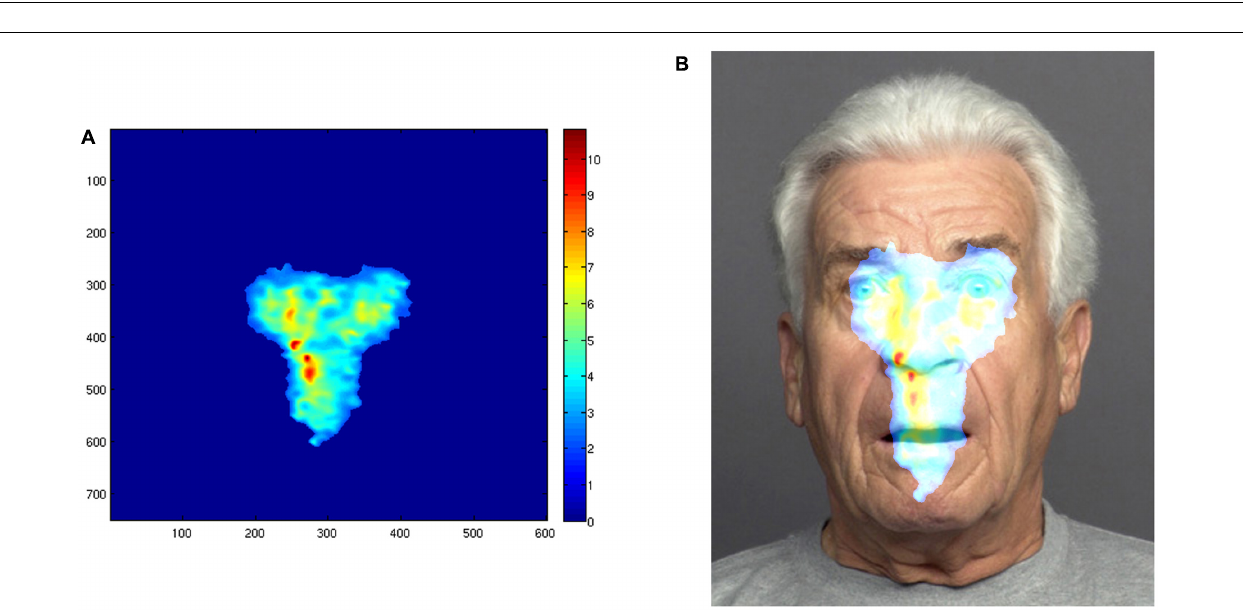
FIGURE 2 | Pixel-wise statistical map showing the number of fixations in the stimulus space of the intuitive group as revealed by the i Map3 analysis. (A) The statistical pattern of distribution of fixations. The colors of the map correspond to fixation counts on that particular area (see color scale on the right). (B) The same pattern mapped onto an example stimulus. A one-tailed Pixel test (Chauvin et al., 2005) was applied for the group fixation map ( p < 1,0). Finally, for each condition average Z -score values were extracted for each observer individually, within the regions showing significance in the differential fixation maps.